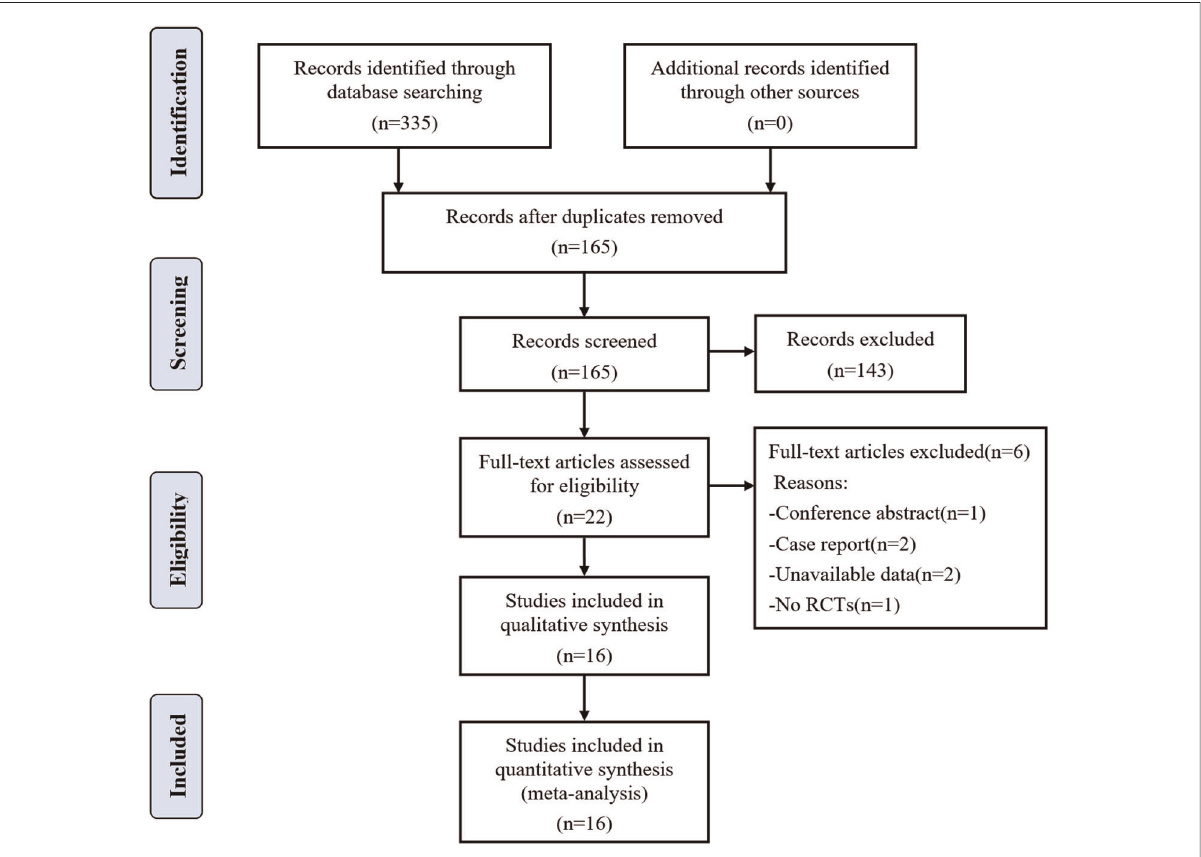
FIGURE 1 Flowchart of the study